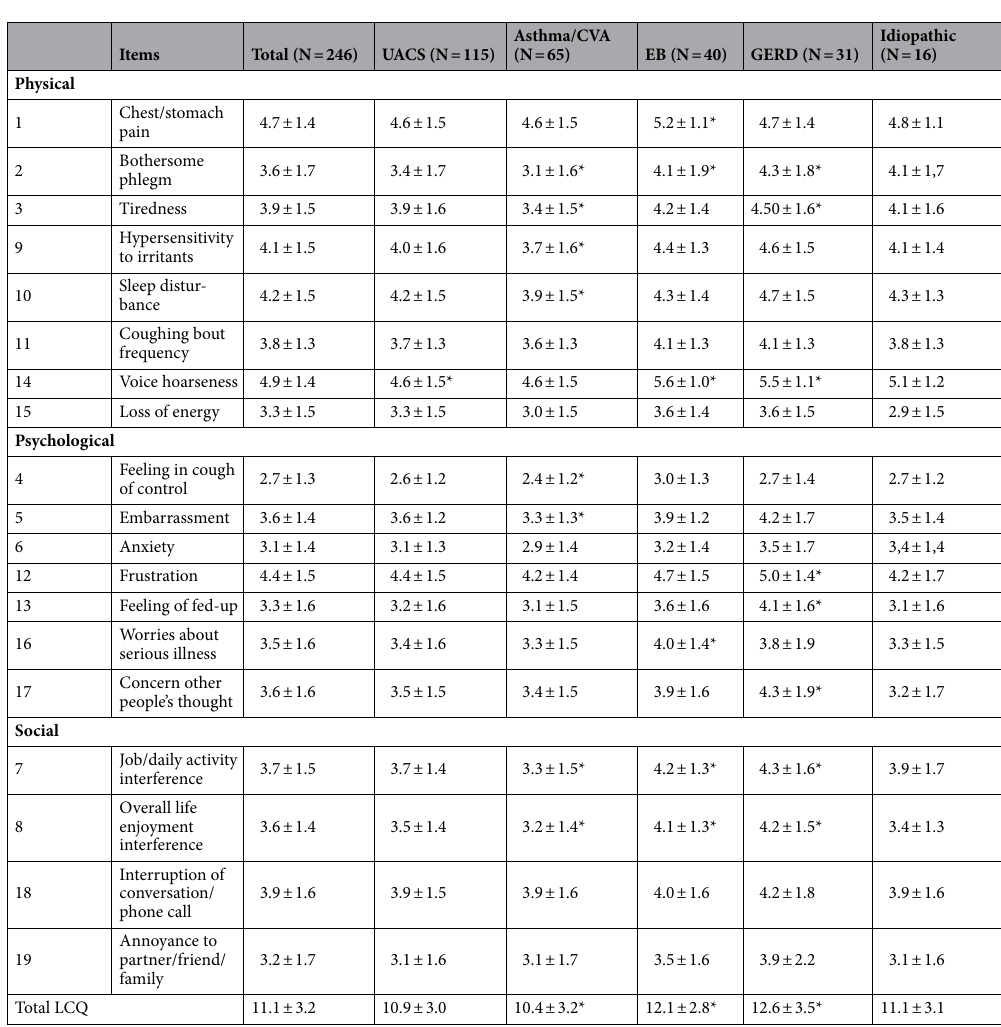
Table 2. Comparison of different phenotype among different causes of chronic cough using K-LCQ. K-LCQ Korean version of Leicester Cough Questionnaire, UACS upper airway cough syndrome, CVA cough